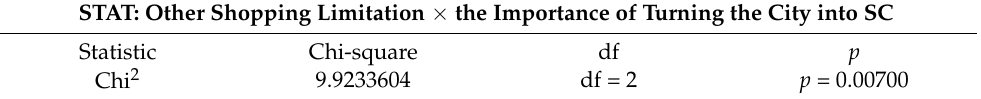
Table 2. The results of the significance level test for two variables: other shopping limitation and the importance of turning the city into SC.